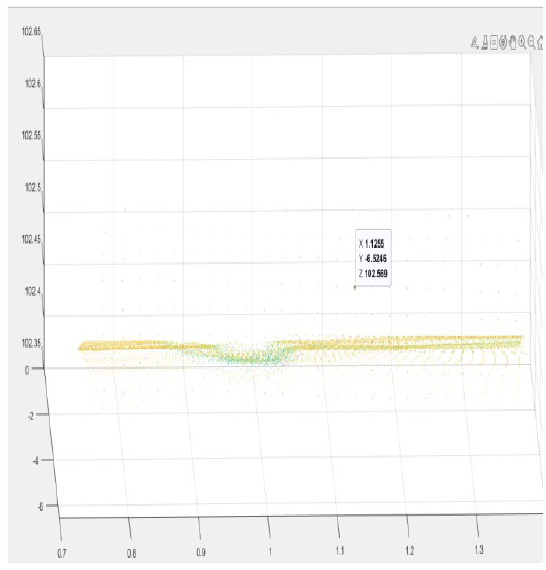
Figure 7(b) . Scattered plot of road